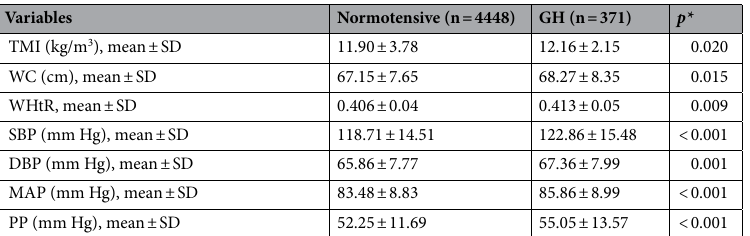
Table 1. Maternal and offspring characteristics according to maternal normotension or gestational hypertension during pregnancy. GH gestational hypertension, SGA small for gestational age, AGA appropriate for gestational age, LGA large for gestational age, BMI body mass index, PI ponderal index, NBP normal blood pressure, HBP high blood pressure, WC waist circumference, TMI tri-ponderal mass index, WHtR waist-to- height ratio, SBP systolic blood pressure, DBP diastolic blood pressure, MAP mean arterial pressure, PP pulse pressure. Values are numbers (percentages) and mean ± SD (standard deviation). *P < 0.05 vs. the normotensive group (z test).